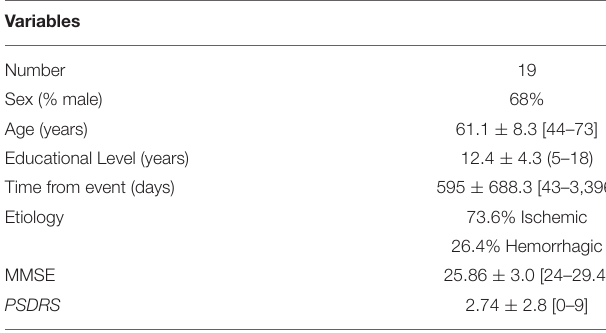
TABLE 1 | Demographic and clinical data at admission to telerehabilitation (TR)